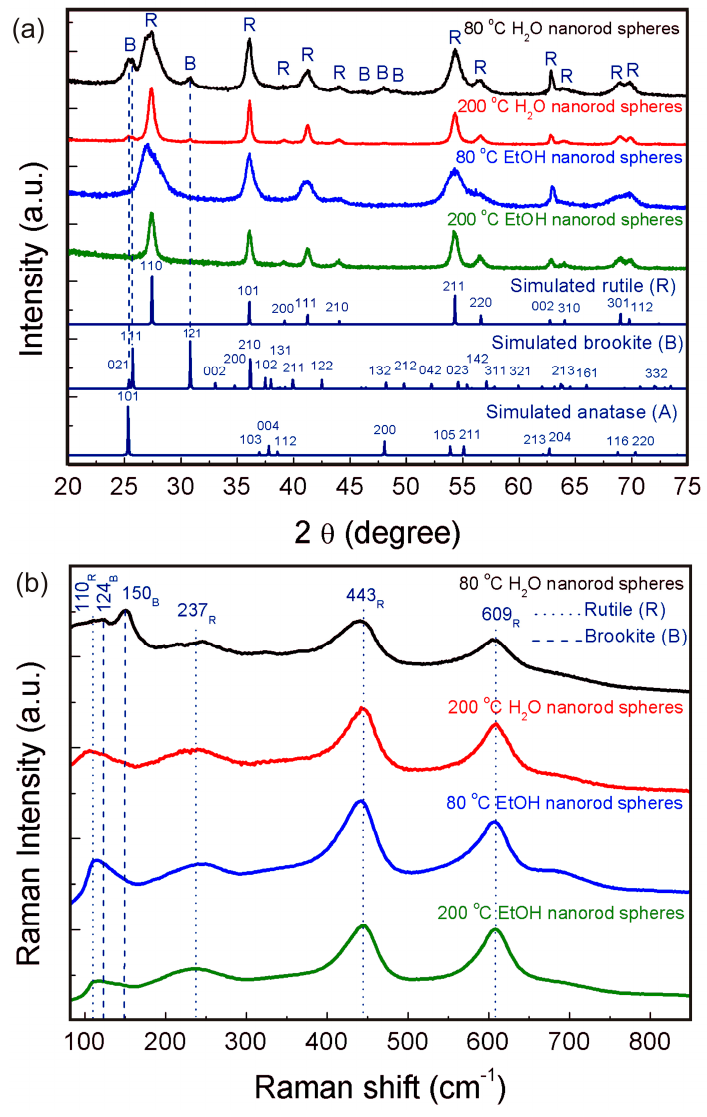
Figure 1. ( a ) XRD diffractograms from the TiO 2 nanorod spheres produced using water and ethanol at 80 and 200 °C. For comparison, experimental data are presented together with the simulated rutile, brookite and anatase diffractograms. ( b ) Raman spectra of the TiO 2 nanorod spheres. Dot lines indicate the rutile bands and dashed ones point out to the brookite ones.